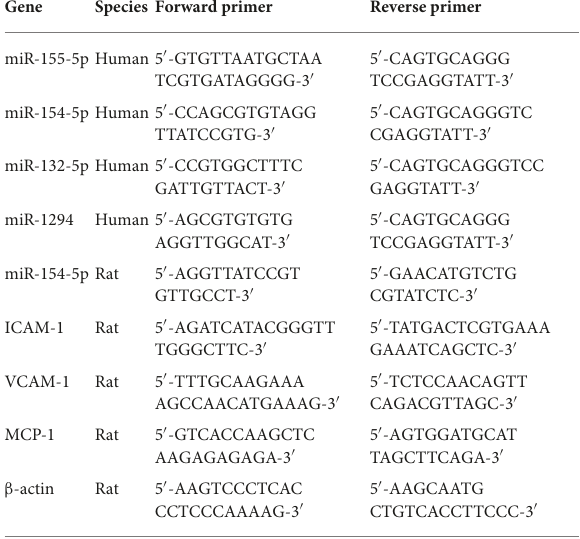
TABLE 1 Primers used for RT-PCR analysis. Gene Species Forward